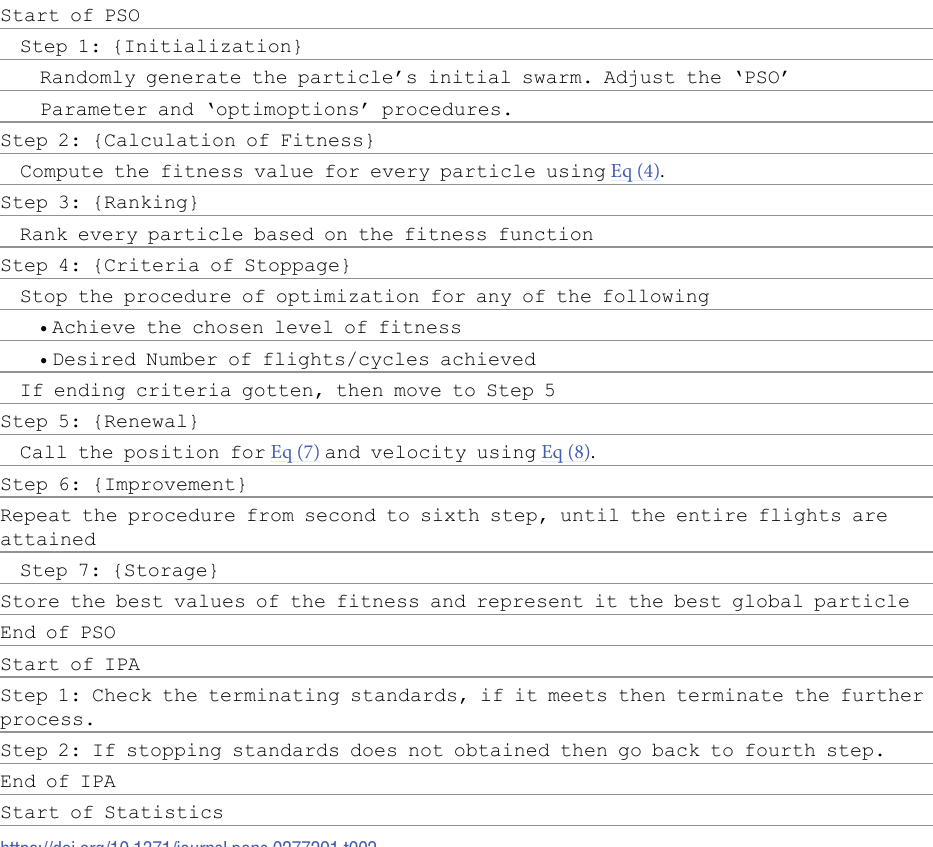
Table 2. Pseudocode of PSO-IPA to solve the SSP-BVPs. Start of